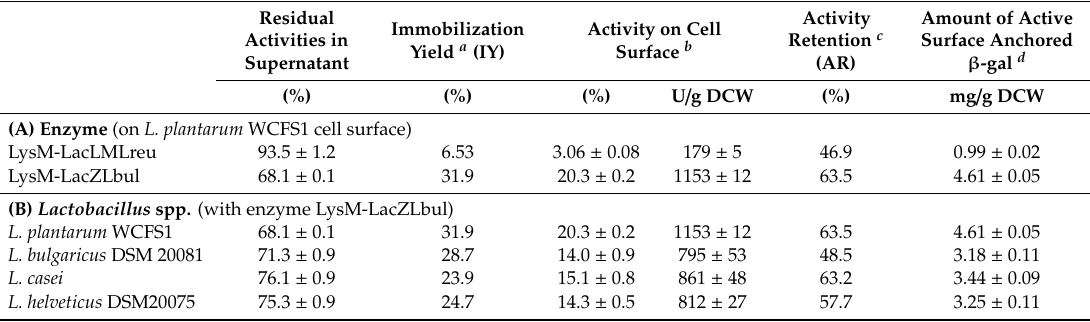
Table 2. Immobilization of ( A ) recombinant lactobacillal β -galactosidases on L. plantarum WCFS1 cell surface and ( B ) recombinant β -galactosidase from L. bulgaricus DSM 20081 (LysM-LacZLbul) on the cell surface of di ff erent Lactobacillus